Question: What form of chart is displayed?
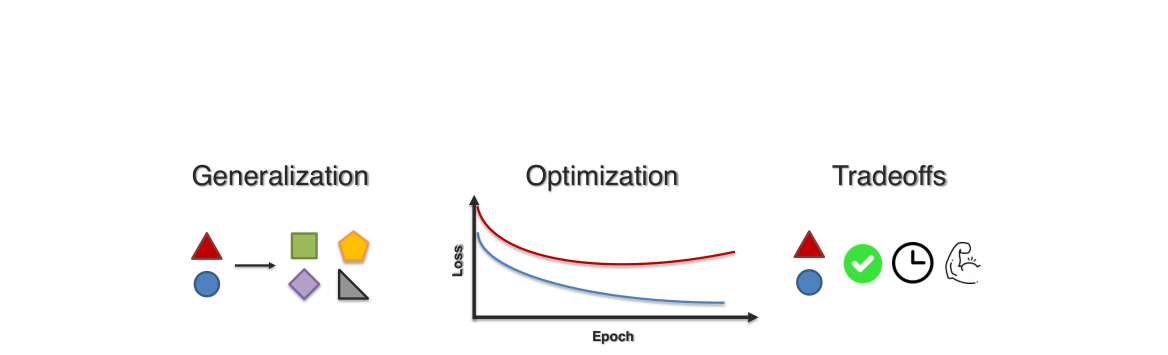
Answer: line